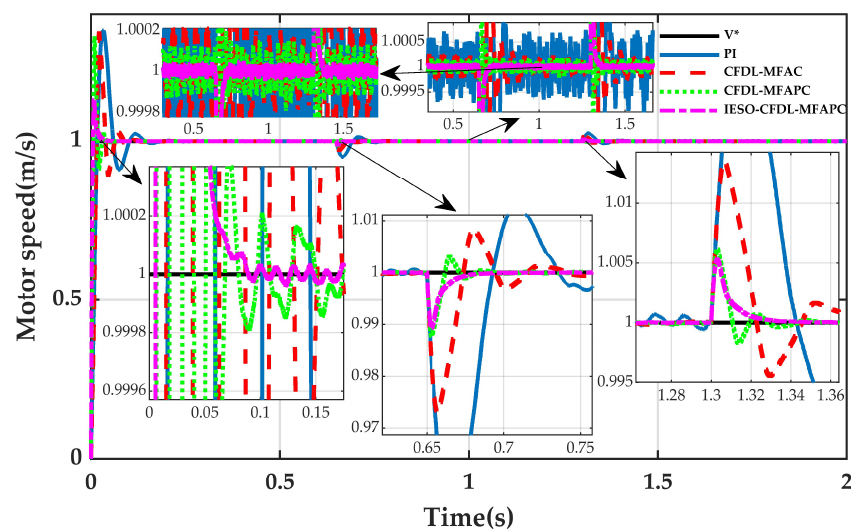
Figure 5. Speed curve for the four control algorithms under sudden load.